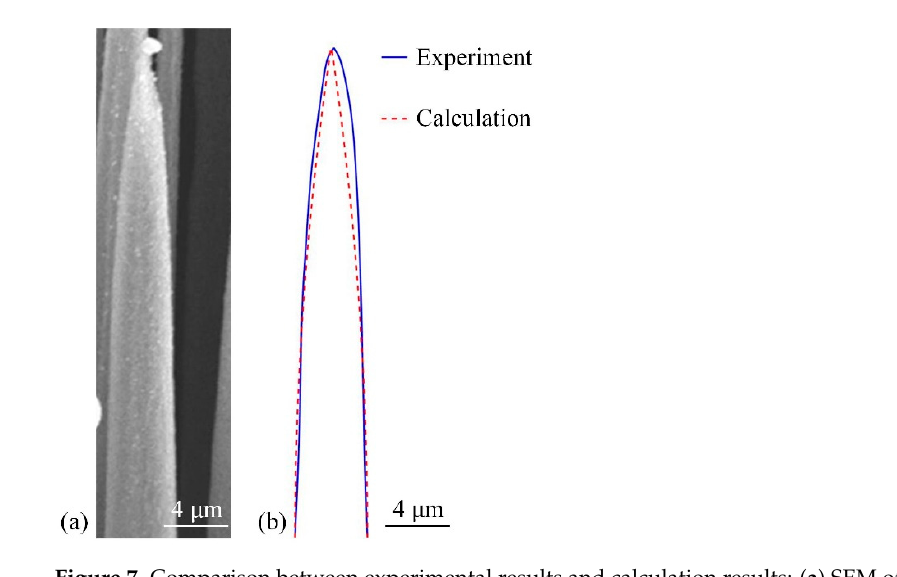
Figure 7. Comparison between experimental results and calculation results: ( a ) SEM of C/C compo- sites oxidized at 1200 °C in air for 15 min, ( b ) experimental results and calculation results.